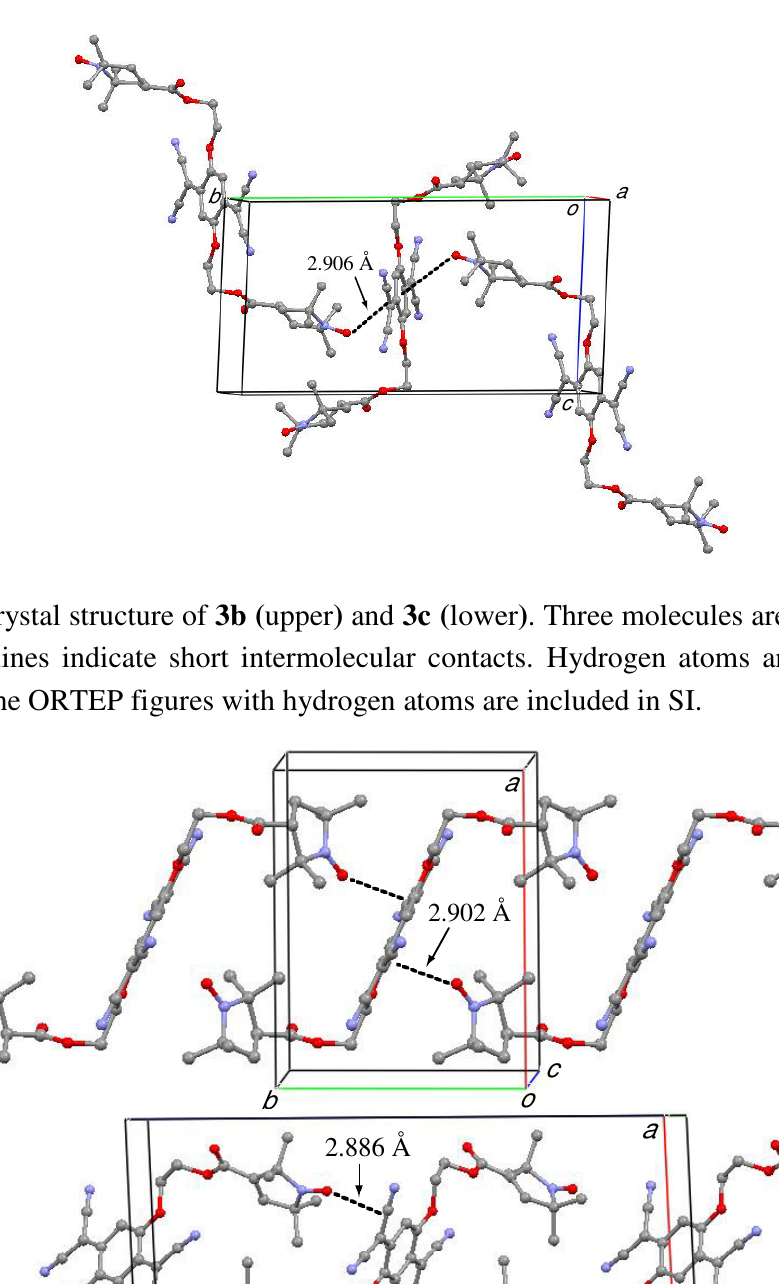
Figure 1. Crystal structure of 3a . Three molecules are depicted and the broken lines indicate short intermolecular contacts. Hydrogen atoms are omitted for clarity and an ORTEP figure with hydrogen atoms is included in Supplementary Information (SI).